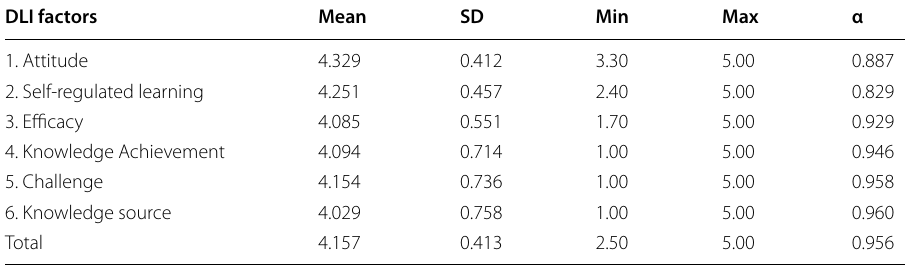
Table 1 Descriptive statistics and reliability for DLI factors DLI factors